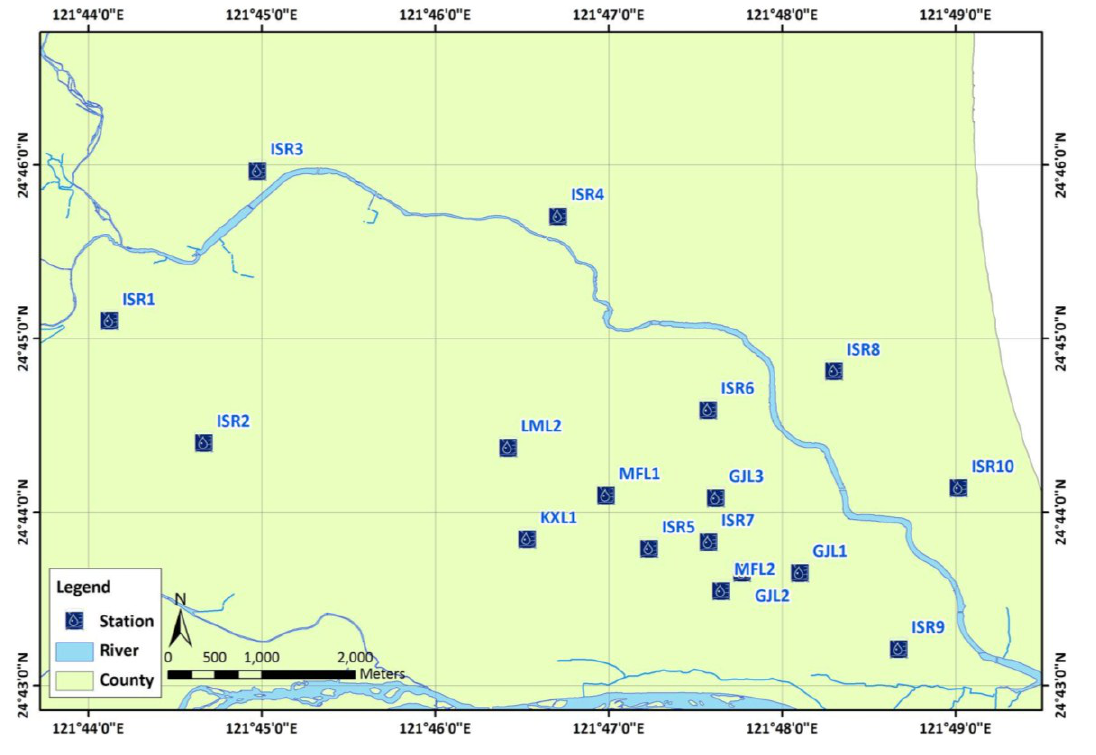
Figure 3. The positions of water level stations in the study area, with the geographic position being the same as that indicated by the yellow square in Figure